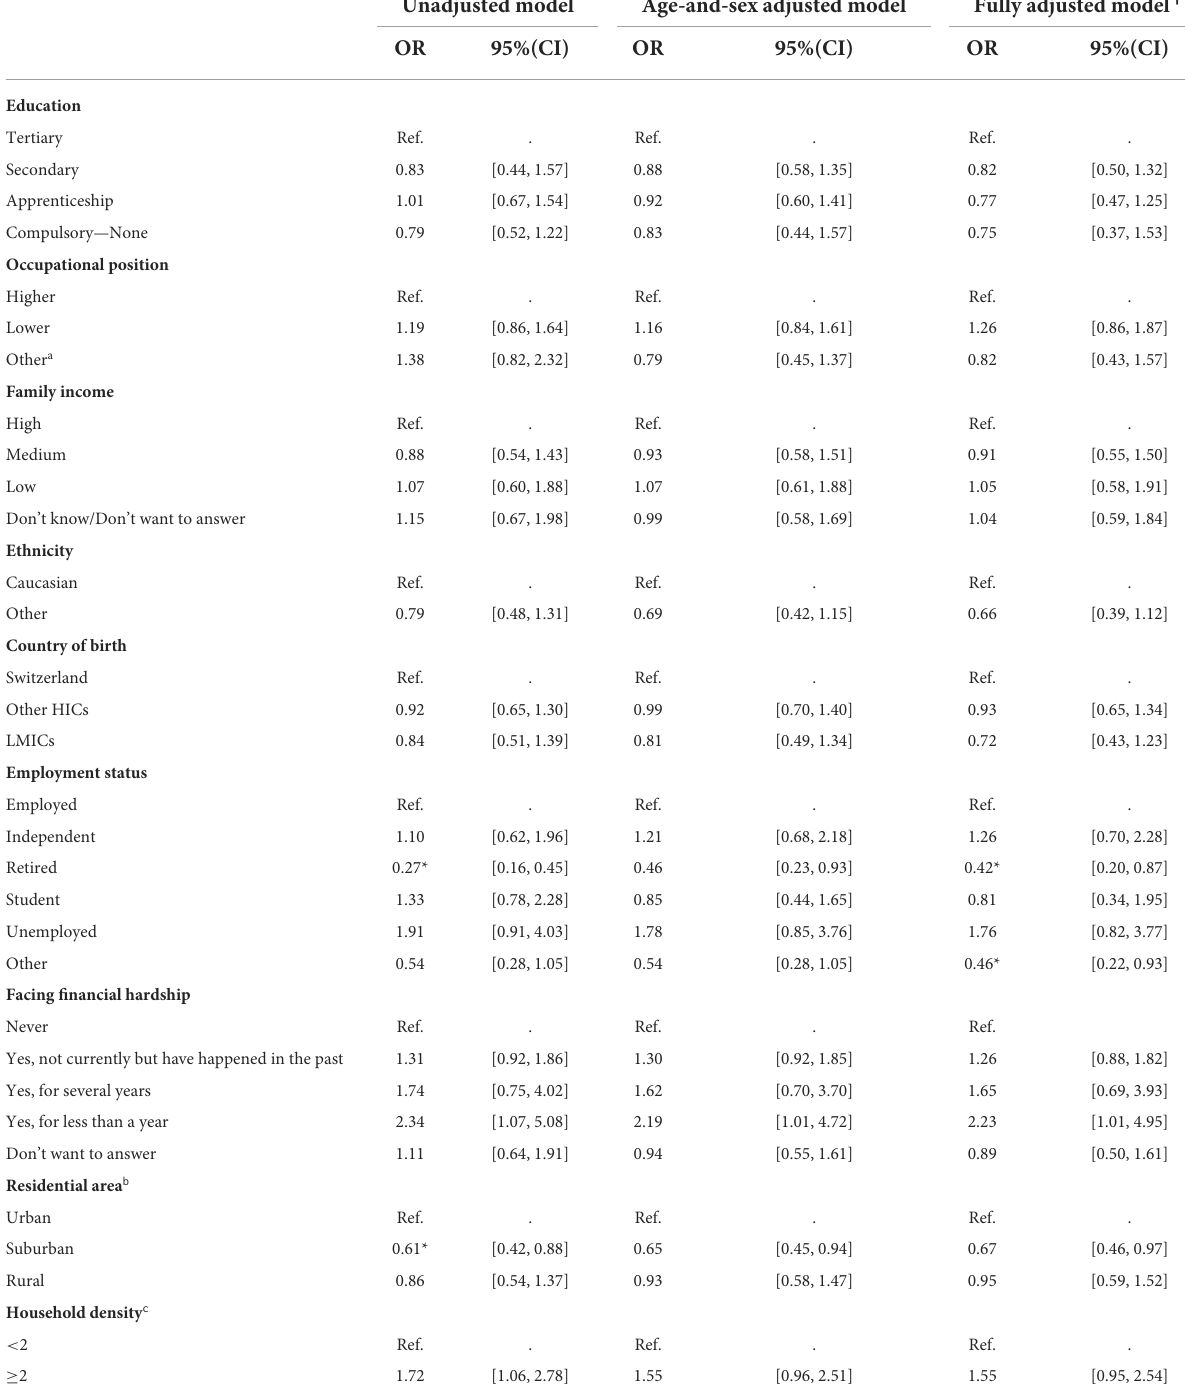
TABLE 1 Association between socio-economic predictors and seropositive status to SARS-CoV-2 in the overall population. Unadjusted model Age-and-sex adjusted model Fully adjusted model + OR 95%(CI) OR 95%(CI) OR